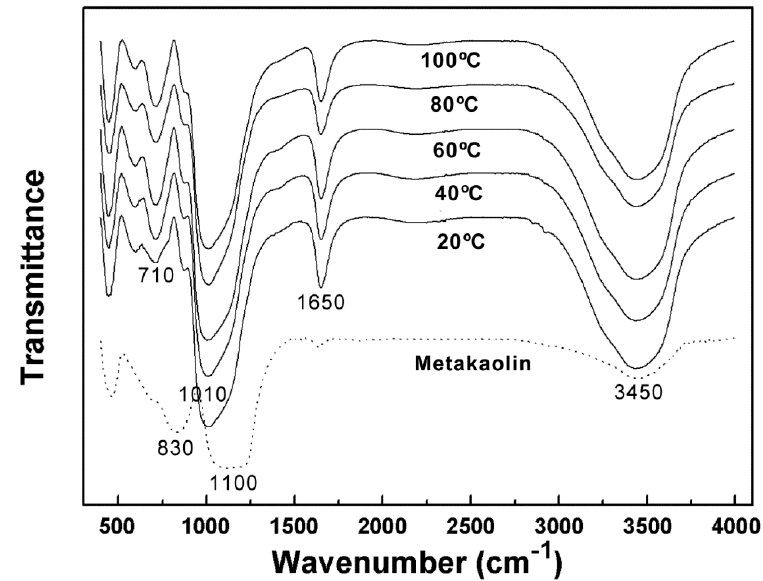
Figure 3. FT-IR spectra of metakaolin and geopolymers cured at different temperature for 24 h.